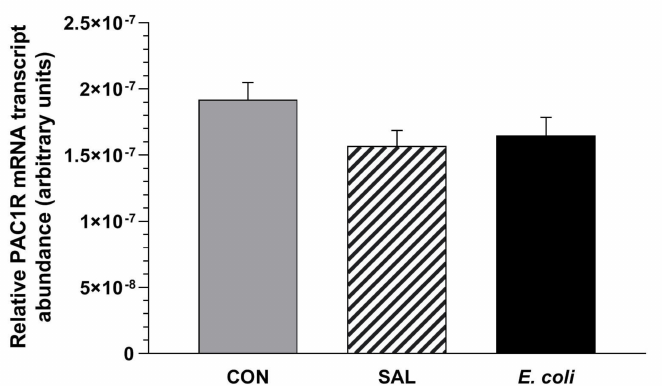
Figure 1. Relative pituitary adenylate cyclase-activating peptide receptor (PAC1R) mRNA transcript abundances in the myometrial layer of gilts from the control (CON), saline (SAL) and E. coli ( E. coli ) groups, estimated by real-time PCR. Relative PAC1R mRNA transcript abundances are expressed as the mean ± SEM of ratios in relation to glyceraldehyde-3-phosphate dehydrogenase (GAPDH).